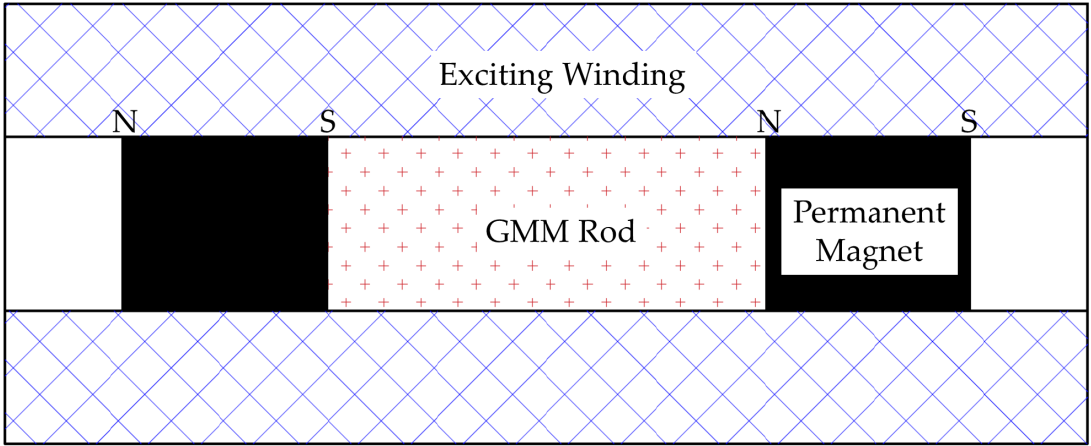
Figure 3. Disk type permanent magnet structure. “N” and “S” stand for magnetic poles.